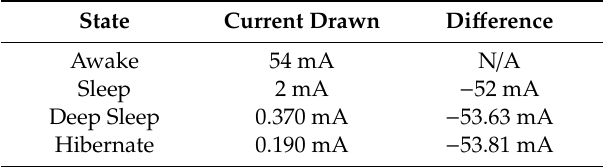
Table 4. Selected voltage characteristics of GPS and dust sensors